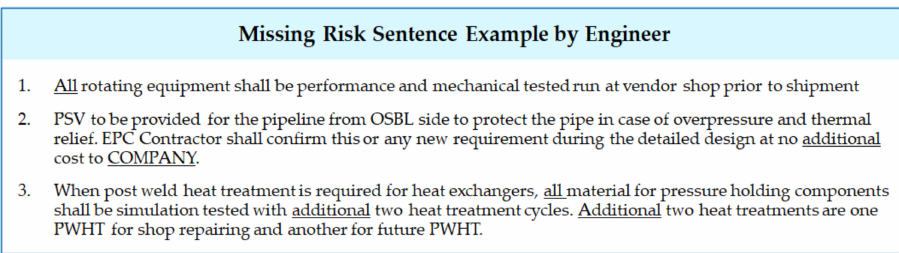
Figure 17. Examples of risk statements omitted by the subject of verification (engineers).